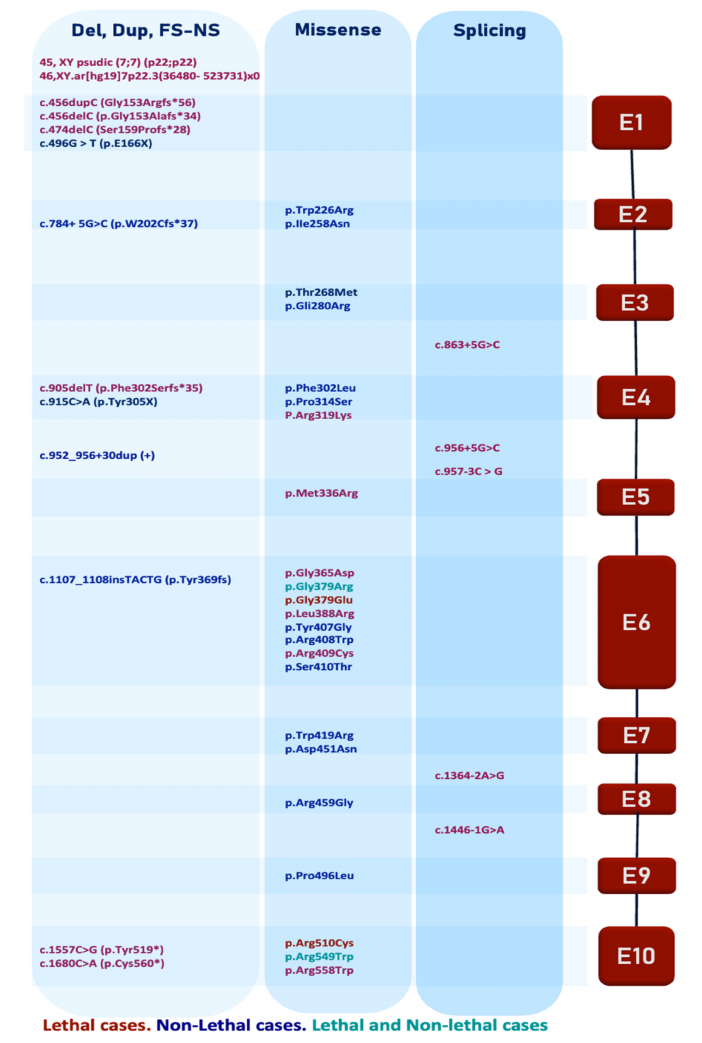
Figure 3. Sequence localization and type of FAM20C pathogenic variants described in Raine syn- drome